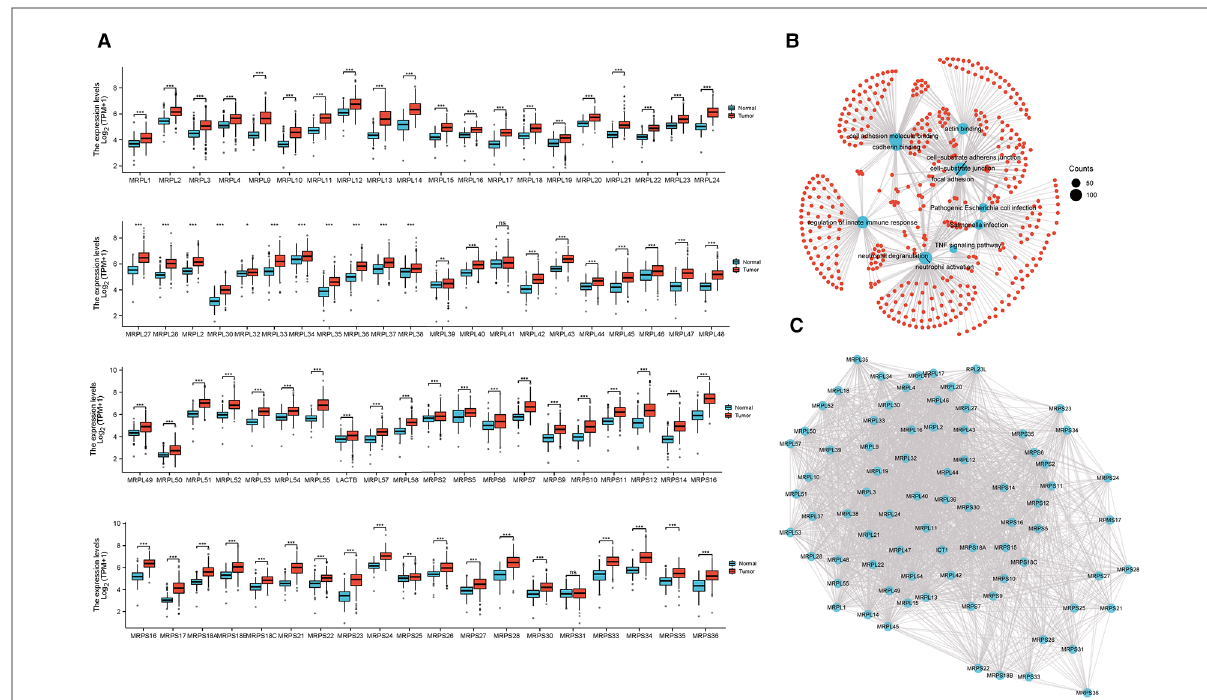
FIGURE 1 Expression and molecular interaction of MRPs. ( A ) Expression of MRPs in HCC and normal tissues combined with TCGA and GTEx data. ( B ) Enrichment analysis of MRPs. ( C ) PPI analysis of